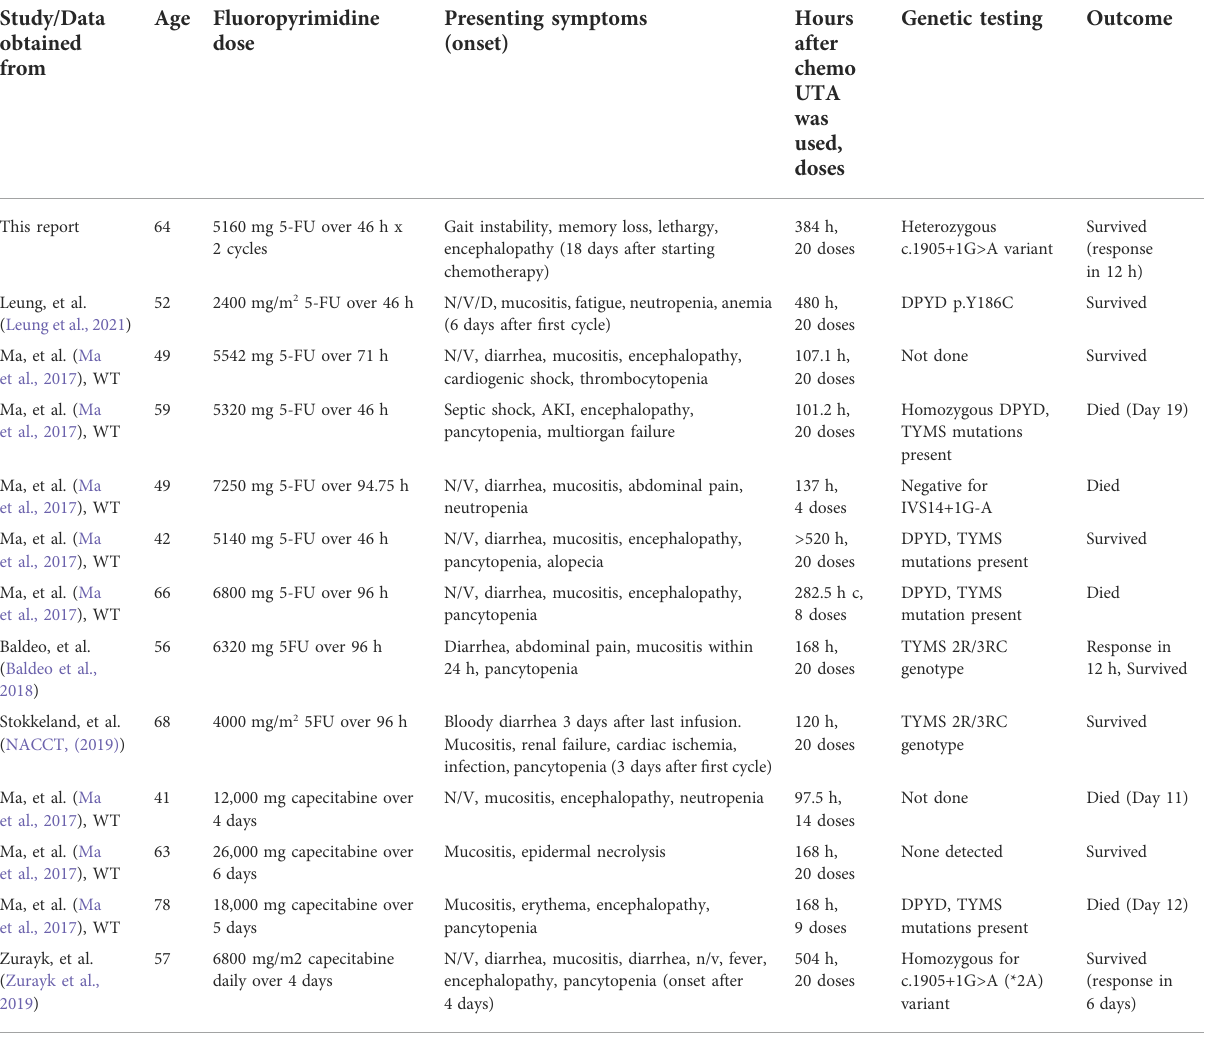
TABLE 1 Cases reporting use of uridine triacetate after the prede fi ned 96-h window after last 5-FU or capecitabine dose. Study/Data